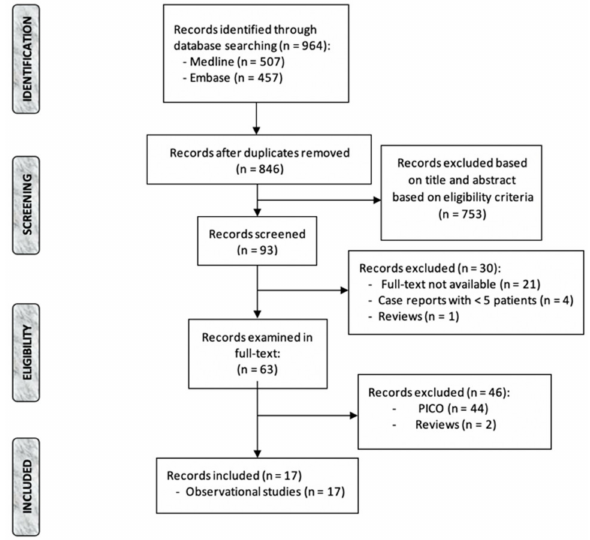
Figure 1. Flow-chart of screening procedure according to the Preferred Reporting Items for Systematic review and Metanalyses (PRISMA) guidelines